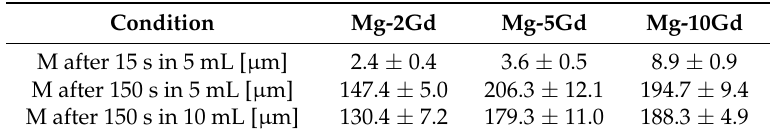
Table 1. Mean value of removed material and standard deviation of six samples for the Mg- x Gd alloys after each etching.